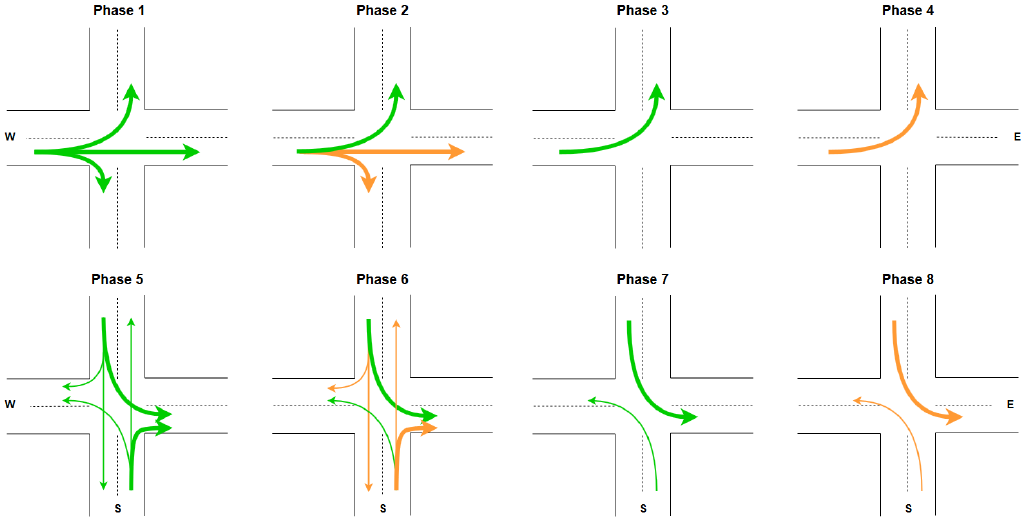
Figure 4. Phases of the traffic lights cycle (only movements from West to East are